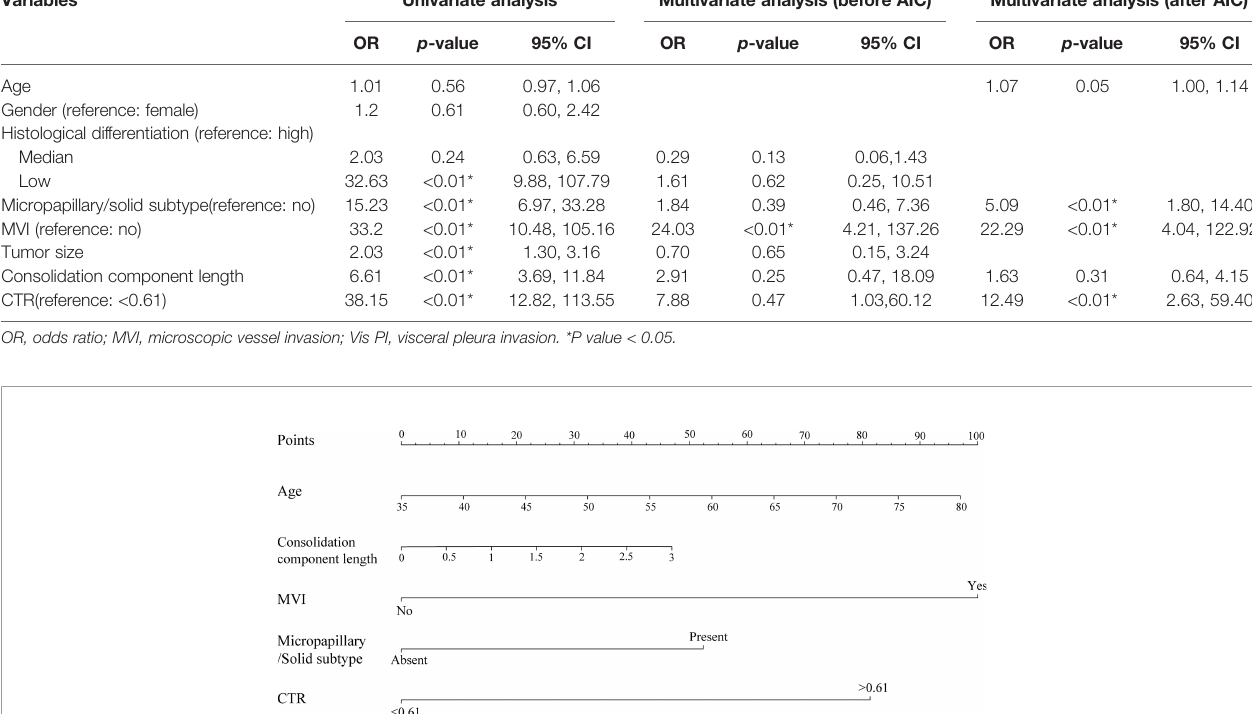
TABLE 4 | Univariate and multivariate analyses of lymph node metastasis. Variables